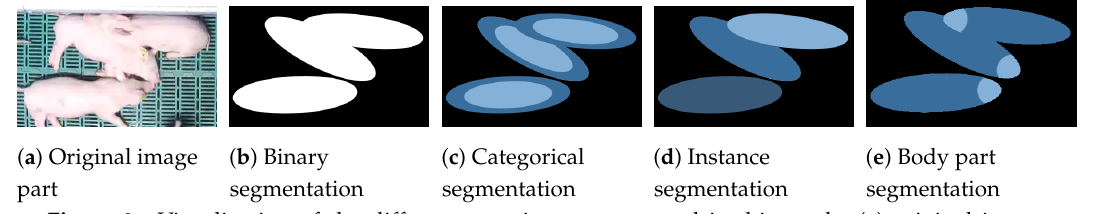
Figure 2. Visualization of the different experiments presented in this work: ( a ) original image; ( b ) The binary segmentation distinguishes only between foreground and background; A categorical segmentation can be used to separate the individual animals ( c ) or to classify body parts ( e ); ( d ) The network is trained to directly tell the affiliation of the pixels to the individual